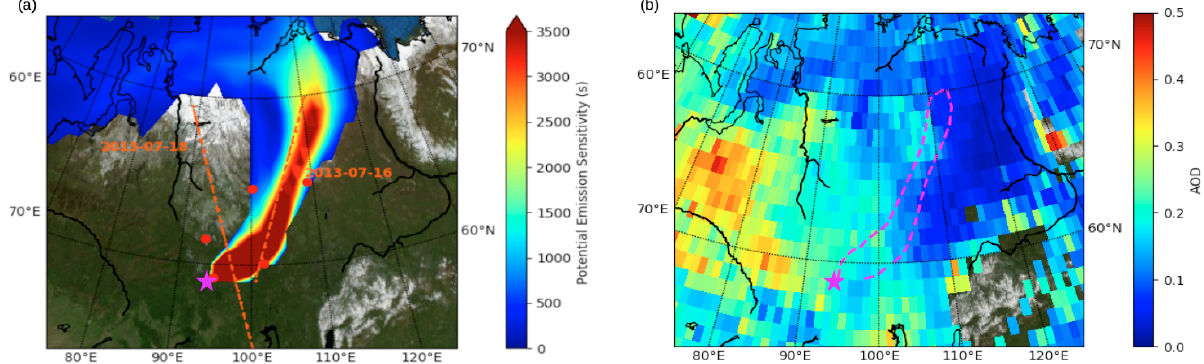
Figure 12. ( a ) as Figure 4a for the aerosol layer of Figure 11. Orange dotted lines are the positions of the two CALIOP overpasses on 16 and 18 July 2013. ( b ) as Figure 4b with averaging of MODIS AOD 550 from 16 to 19 July